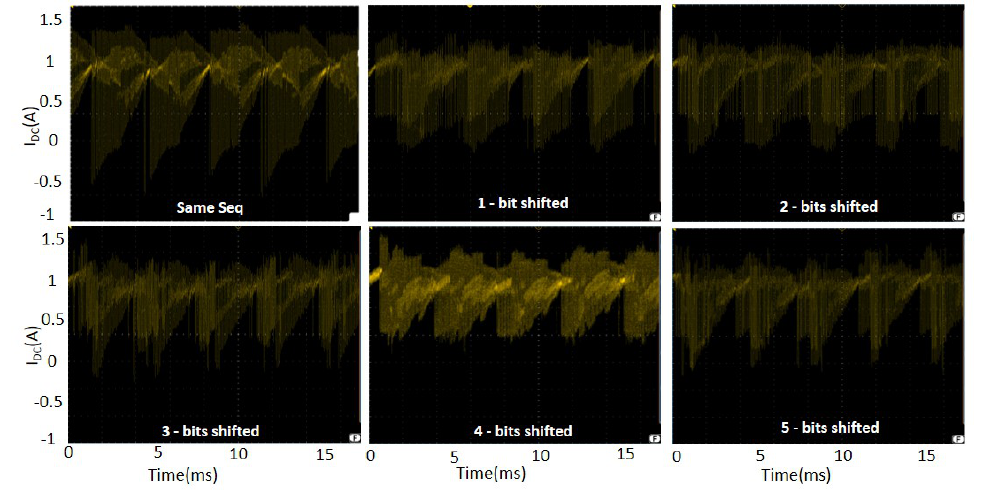
Figure 16. Experimental DC − link current for sequence-shifted interleaving at 20 ◦ pf angle.